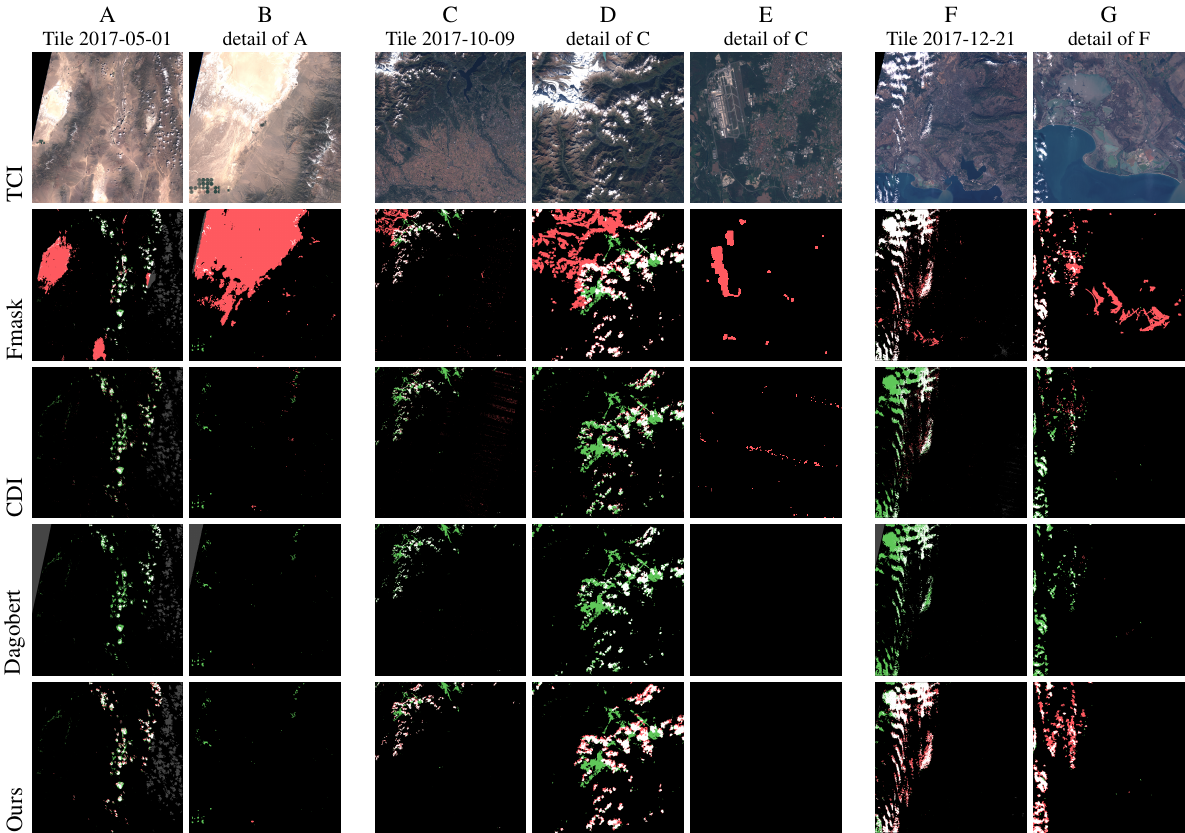
Figure 4. From top to bottom: True Color preview of the Sentinel-2 tile (TCI), Fmask, CDI, Dagobert, and our result. The true positives are displayed in white, and the true negatives in black. The false positives are in red and the false negatives in green. Gray indicates detections not accounted for in the evaluation (nodata class in the ground truth). Details are displayed next to each of the three